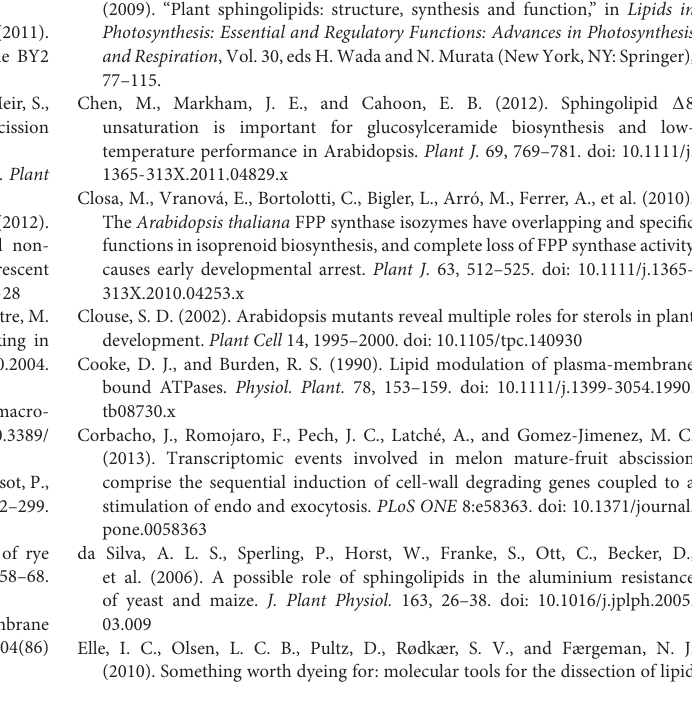
FIGURE S1 | Changes on non-polar/polar lipid ratio of live protoplasts from olive AZ during mature-fruit abscission. Fluorescence of variable colors from protoplast indicating difference in neutral lipid composition: polar lipid appeared as red (A,E) and neutral or non-polar lipid appeared as green (B,F) . (A,B) Nile red stained protoplasts from the olive AZ at the pre-abscission stage compared to the white-light image (C) . (E,F) Nile red stained protoplasts from the olive AZ at the abscission stage compared to the white-light image (G). (D,H) Viability was successfully tested using trypan blue. Scale bars are 5 µ m. (I) Effect of the abscission on non-polar:polar lipid ratio of fruit AZ protoplasts. Columns and bars indicate means ± SD, respectively, from five independent experiments. Statistically significant differences based on unpaired Student’s t -test at P < 0.05 are denoted by